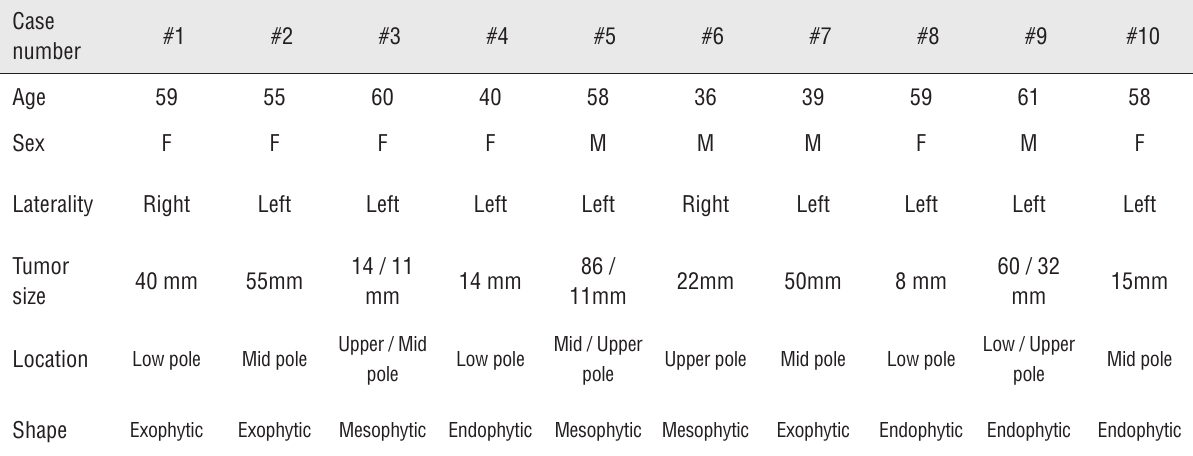
Table 1 - Baseline characteristics of all patients.